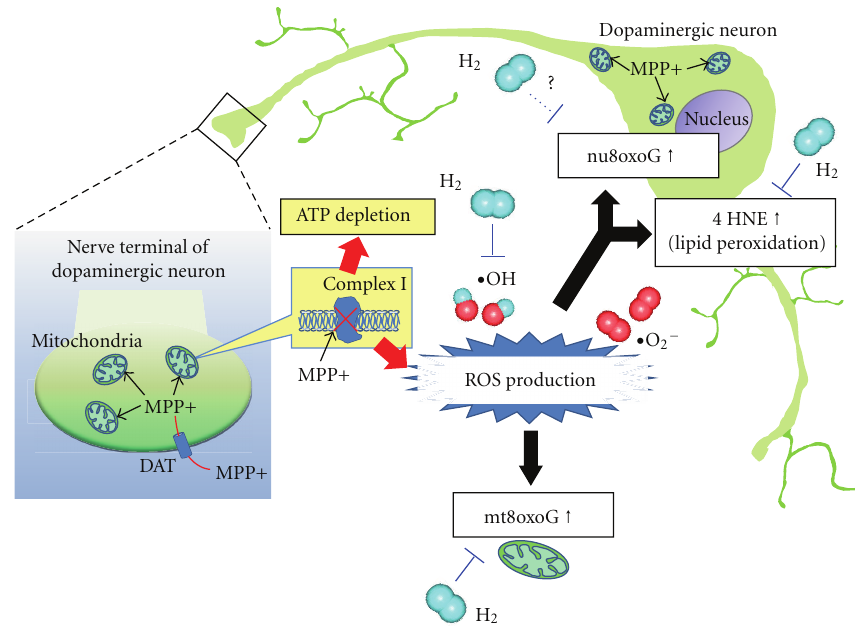
Figure 2: The e ff ects of hydrogen in oxidative stress-derived neural apoptosis in dopaminergic cells. Hydrogen (H 2 ) selectively reduces hydroxyl radical ( • OH) by direct reaction, and decreased oxidative damage such as mitochondrial/nuclear 8-oxoG (mt8oxoG/nu8oxoG) accumulation, and 4-hydroxynonenal (4-HNE) production in dopaminergic neurons. Each oxidative damage is involved in di ff erent neuronal apoptosis. Abbreviation; MPP + : 1-methyl-4-phenylpyridinium ion, DAT: dopamine transporter, ROS: reactive oxygen species, ATP: adenosine 5 (cid:3) -triphosphate, • OH: hydroxyl radical, • O 2 − : superoxide, 4-HNE: